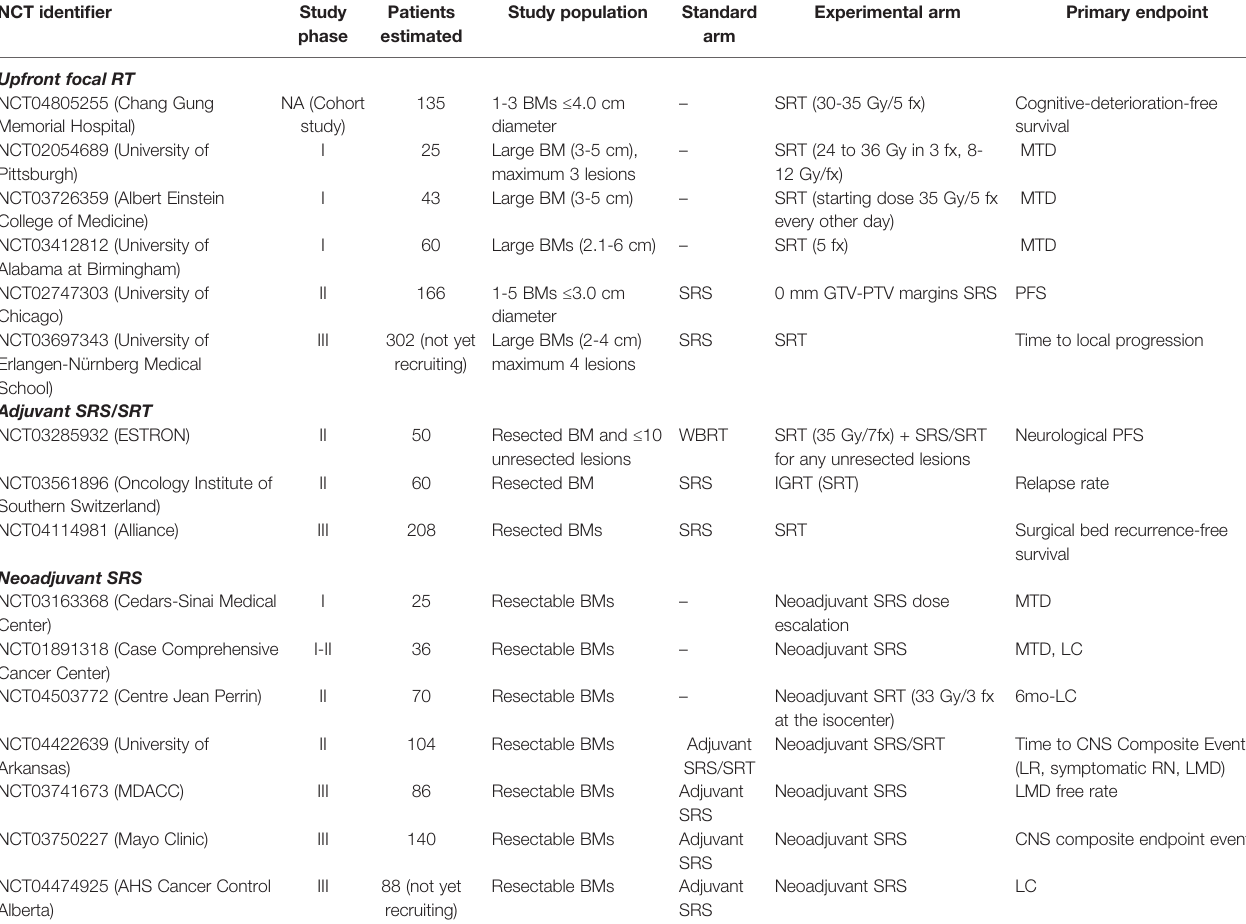
TABLE 1 | Currently ongoing clinical trials investigating RT for oligometastatic